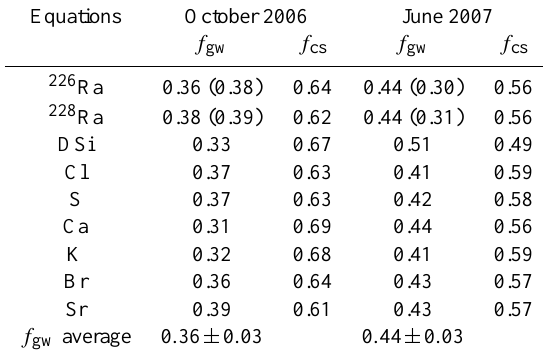
Table 3. Coastal plume water fractions of brackish groundwater ( f gw ) and seawater ( f cs ) derived from the mixing models with the set of tracers. Groundwater fractions shown in brackets are calcu- lated assuming the same groundwater radium average for the two samplings (see text for details).